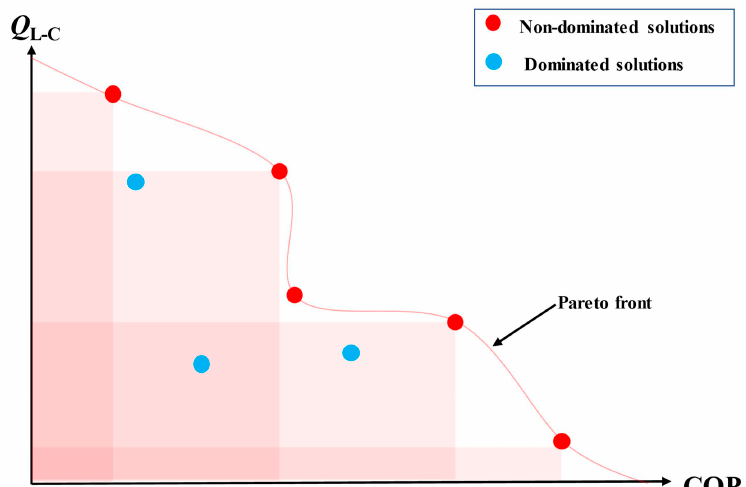
Figure 3. Schematic of the Pareto concept.